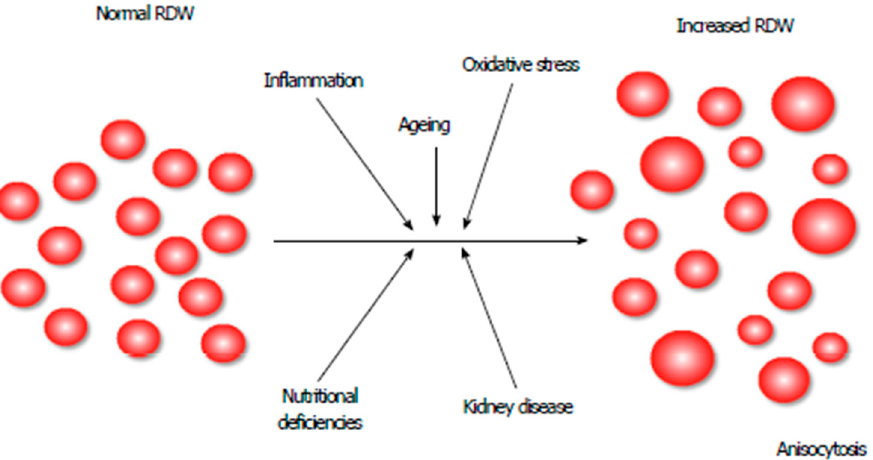
Figure 2. Pathophysiological mechanisms causing anisocytosis. RDW: red blood cell distribution width [13].